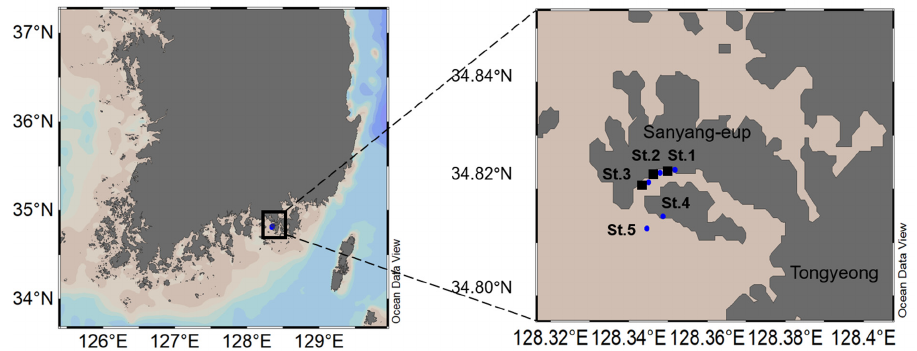
Figure 1. Map showing sampling stations in Tongyeong Sanyang-eup on the southern coast of Korea. Blue circles indicate sampling stations. Aquaculture fish farms were located near Stations 1–3, while no fish farms were deployed around Stations 4 and 5. Arrows indicate the direction of current movement in the study region. Blue circles are sampling stations and black squares denote the location of aquaculture fish cages.